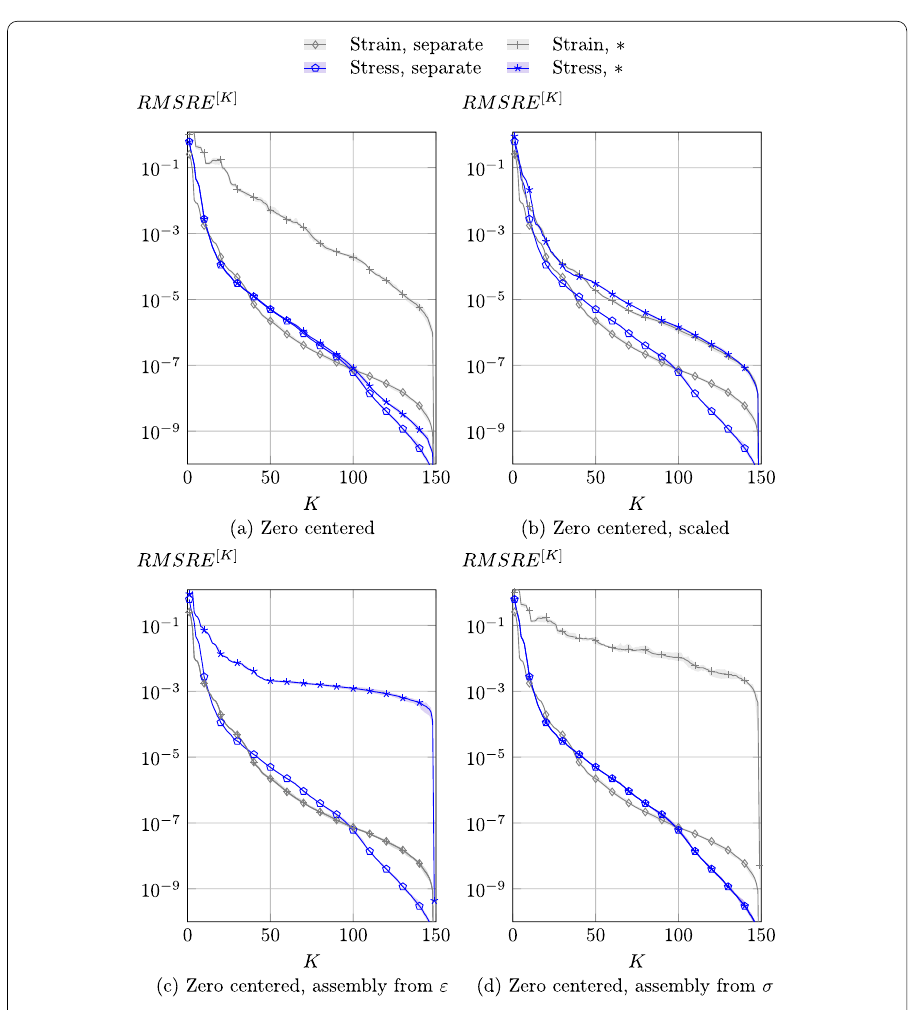
Fig. 6 Truncation error ( κ RMSRE [ K ] ) using different methods compared to separate decomposition of the pure bending problem. The solid line represents the mean over the 5 training sets with markers every 10 basis vectors. The shaded area represents the range over all training sets